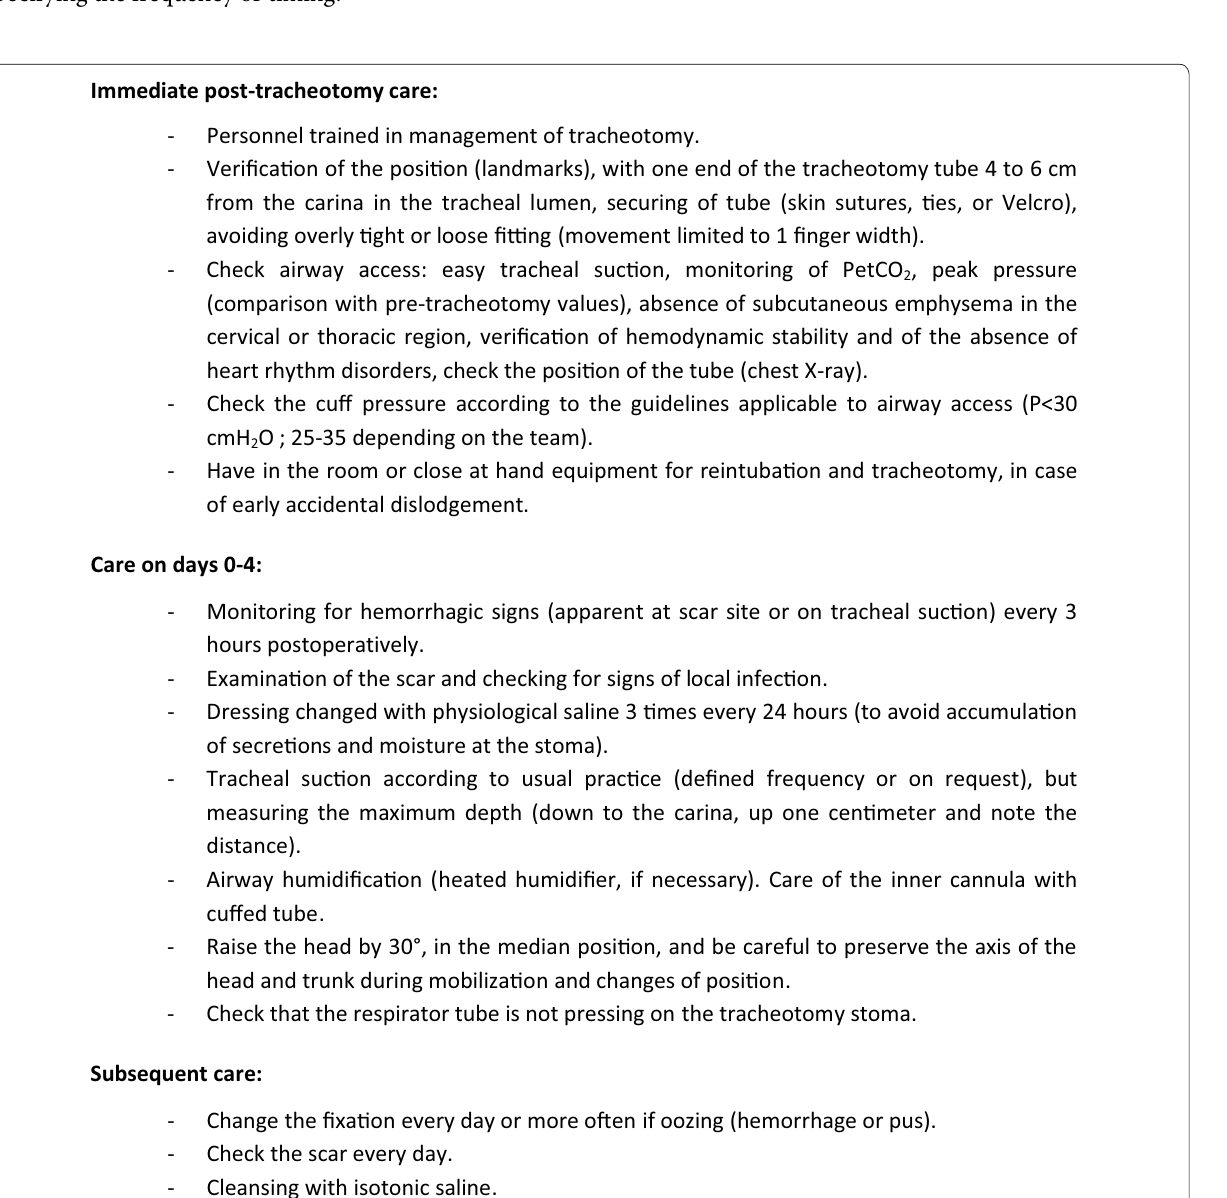
Fig. 3 Proposed care protocol associated with guideline 4.1 (Expert